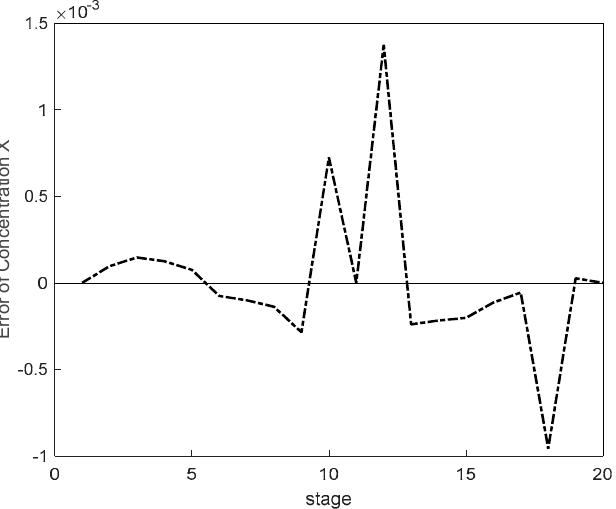
Figure 4. Concentration distribution curve and its expansion curve. Figure 5 shows the estimated errors of liquid component concentrations predicted by Equations (12) and (13). The parameters are determined by a simple least squares method. The largest prediction error is approximately 1 × 10 − 3 , mainly around the feed tray with a strong interference factor. The results show that the solution by Equations (12) and (13) can be used to describe the shape of the distribution curve with relatively high precision.